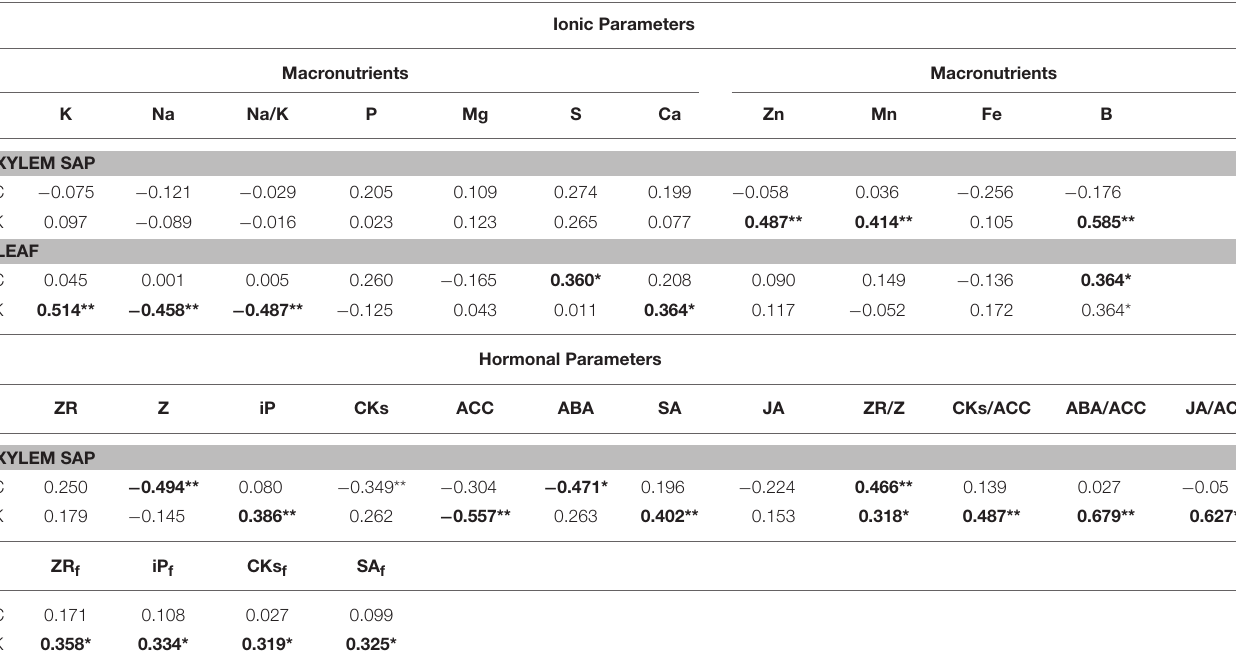
TABLE 2 | Linear correlation coefficients between shoot fresh weight (SFW) and ionomic and hormonal related parameters in the root xylem sap of the scion ( Solanum lycopersicum cv. Boludo F1) grafted onto a population of recombinant inbred lines (RILs) from a cross between Solanum lycopersicum × Solanum pimpinellifolium with high (H) or low (L) vigour growing under control (c) and low K (k) conditions during 48